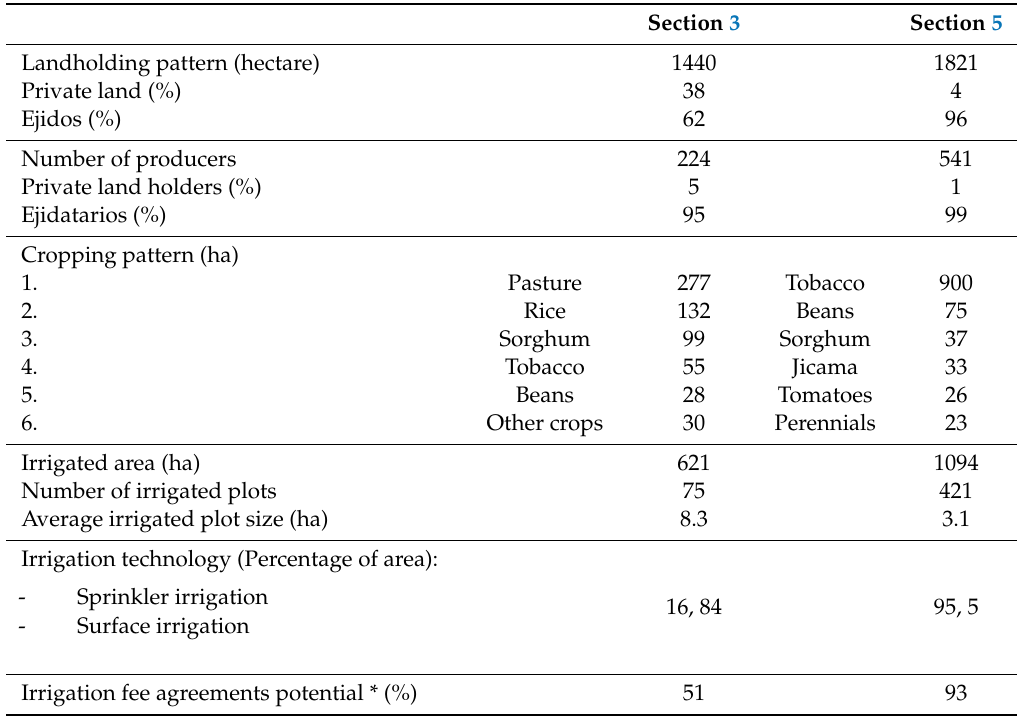
Table 1. Sections 3 and 5 in Autumn–Winter